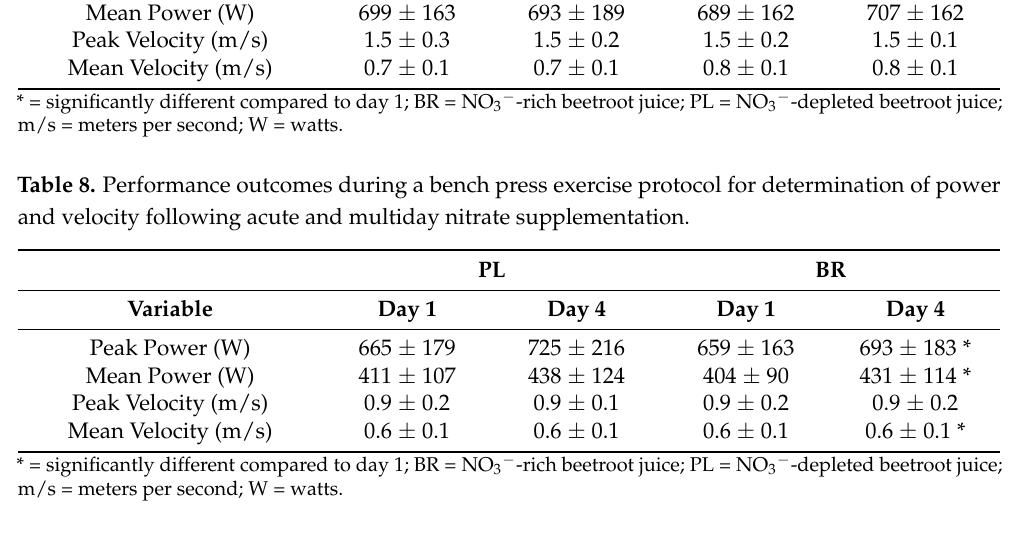
Table 9. Performance outcomes during a back squat exercise protocol for determination of muscular endurance following acute and multiday nitrate supplementation.